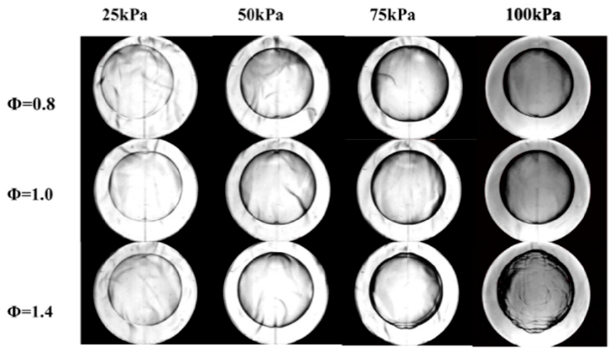
Figure 5. Schlieren images of flames acquired at different pressures and equivalence ratios at 450 K.